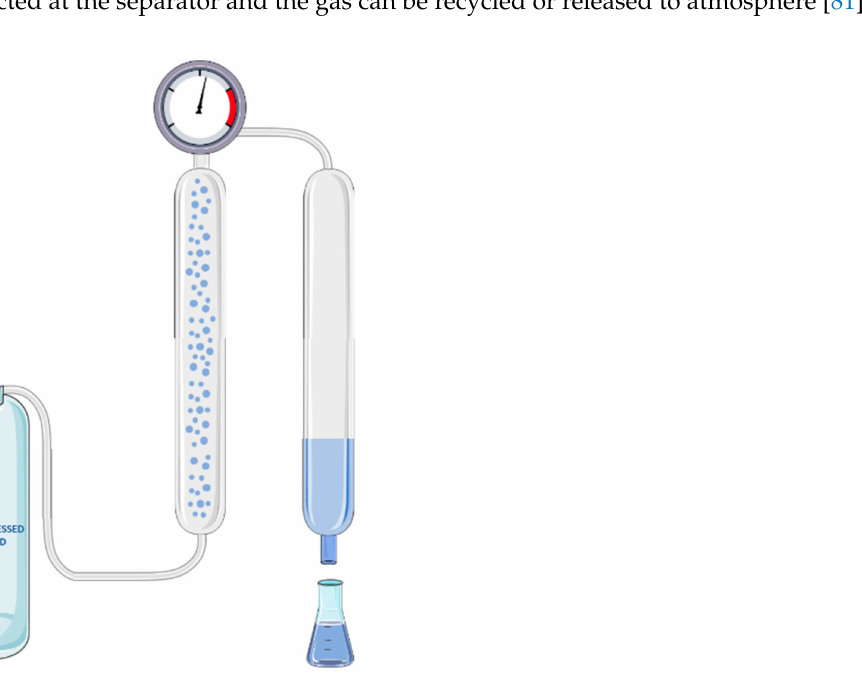
Figure 1. Schematic illustration of the compressed fluid-based extraction process. This figure was made with some free images available on the Smart Servier Medical Art website (https://smart. servier.com, last accessed on 22 December